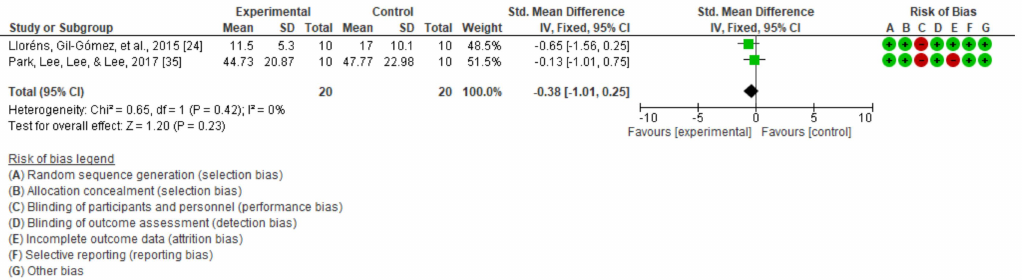
Figure 7. Dynamic balance as measured using the 10 m test.